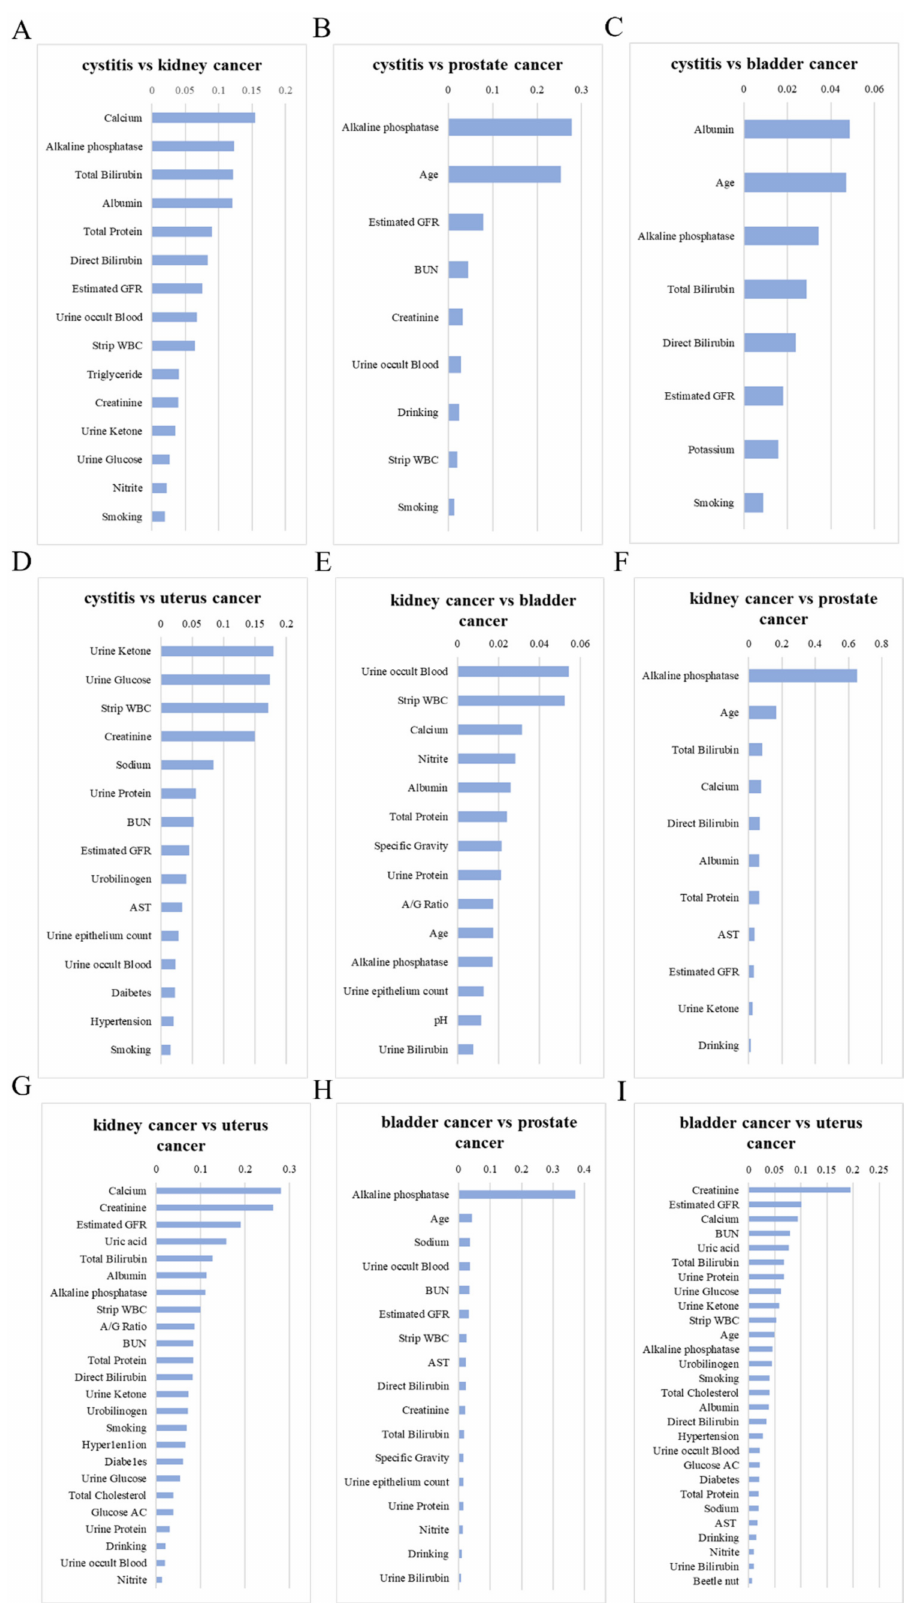
Figure 1. The feature selection results of ( A ) cystitis vs. kidney cancer, ( B ) cystitis vs. prostate cancer, ( C ) cystitis vs. bladder cancer, ( D ) cystitis vs. uterus cancer, ( E ) kidney cancer vs. bladder cancer, ( F ) kidney cancer vs. prostate cancer, ( G ) kidney cancer vs. uterus cancer, ( H ) bladder cancer vs. prostate cancer, and ( I ) bladder cancer vs. uterus